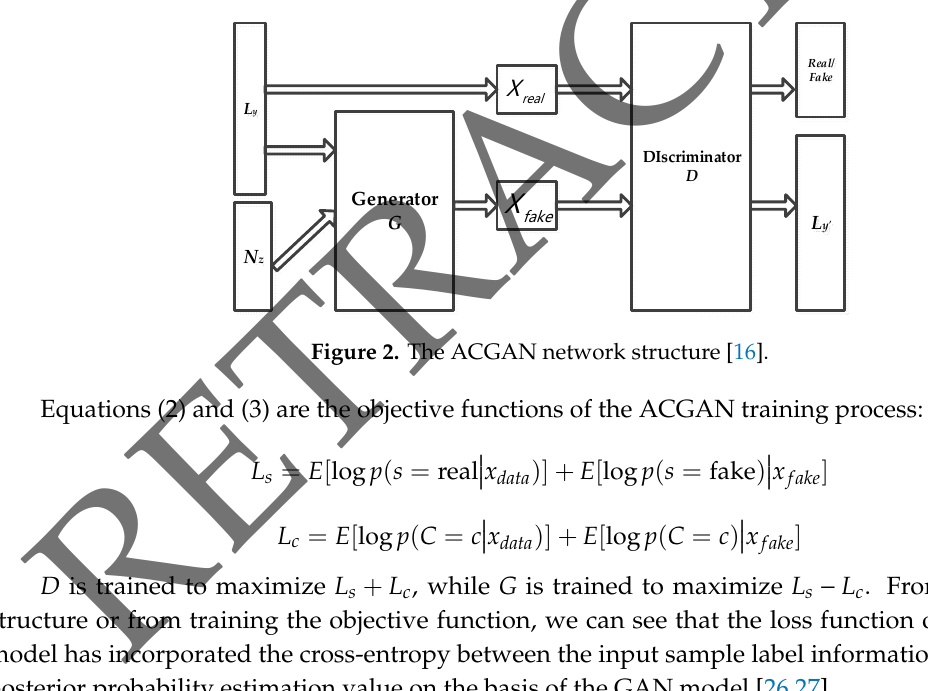
Figure 2. The ACGAN network structure [16].